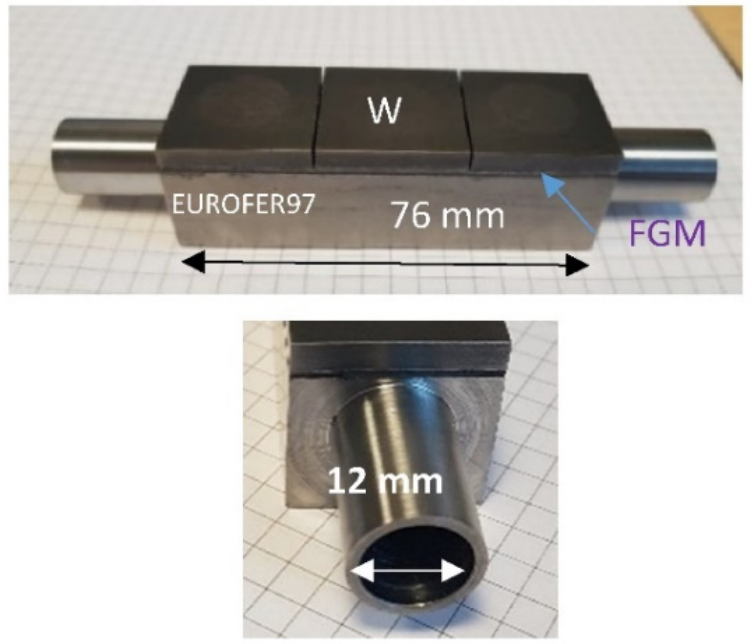
Figure 3. Mock-up equipped with FGM (Ta, 50 vol.% Ta + 50 vol.% Ti, Ti) as joining solution between Figure 3. Mock ‐ up equipped with FGM (Ta, 50 vol.%Ta + 50 vol.%Ti, Ti) as joining solution between W and Eurofer97: top — side view; bottom — tube view. W and Eurofer97: top—side view; bottom—tube